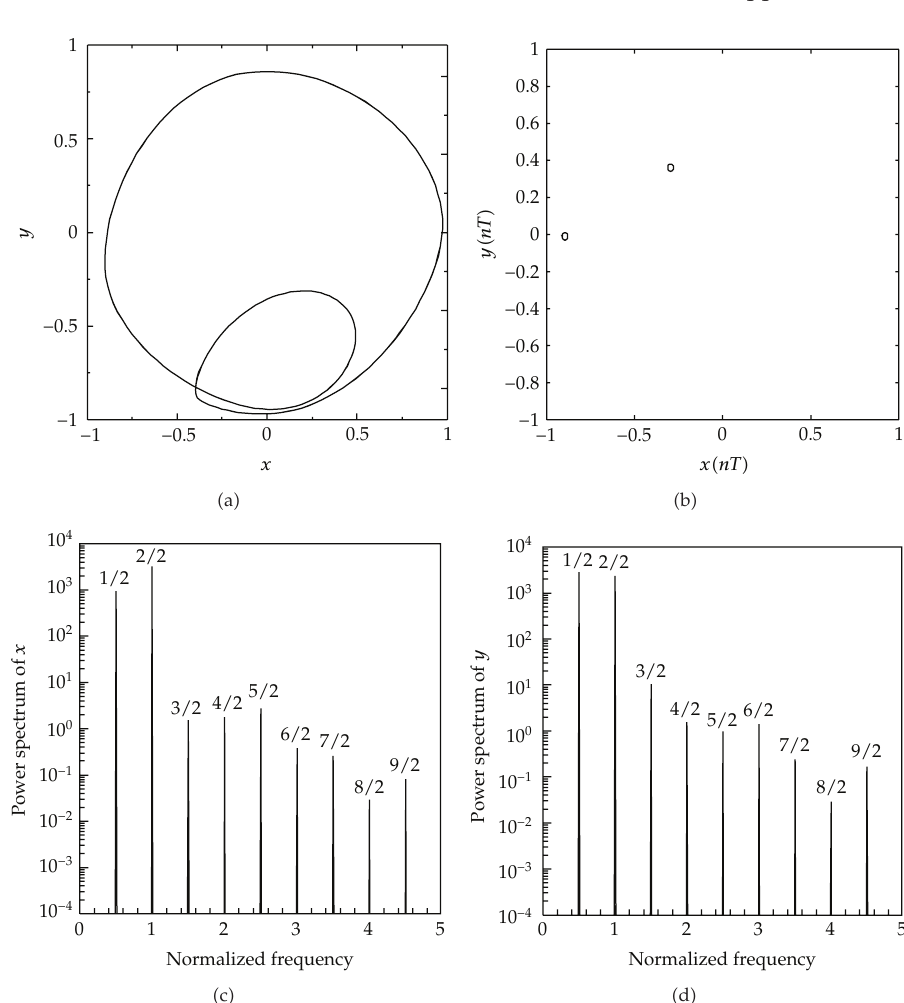
Figure 4: Subharmonic motion at s (cid:8) 2 . 6 (cid:2) case 1 (cid:3) ; (cid:2) a (cid:3) Rotor trajectory; (cid:2) b (cid:3) Poincar´e map; (cid:2) c (cid:3) and (cid:2) d (cid:3) Displacement power in X and Y directions (cid:2) without rub-impact e ff ect (cid:3)